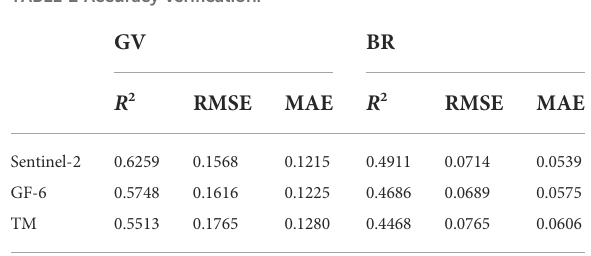
TABLE 2 Accuracy veri fi